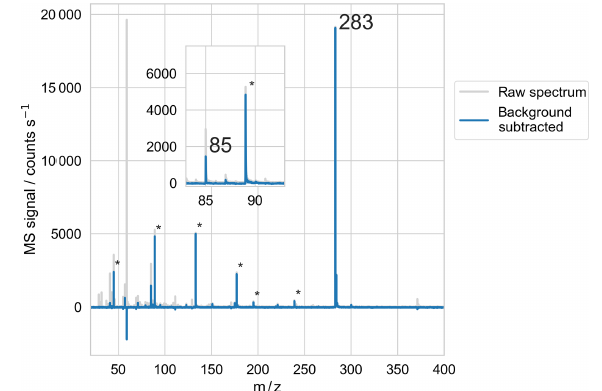
Figure 4. Sample mass spectrum of droplet trapped in EDB and measured with MS, using the BD + PEG-6 + NaCl ( X NaCl = 0 . 140) experimental solution. Both the raw and background- subtracted spectra are shown. Butenedial is observed at its parent ion of 85 m/z . PEG-6 is observed at its parent ion of 283 m/z , along with at known fragment m/z labeled with ∗